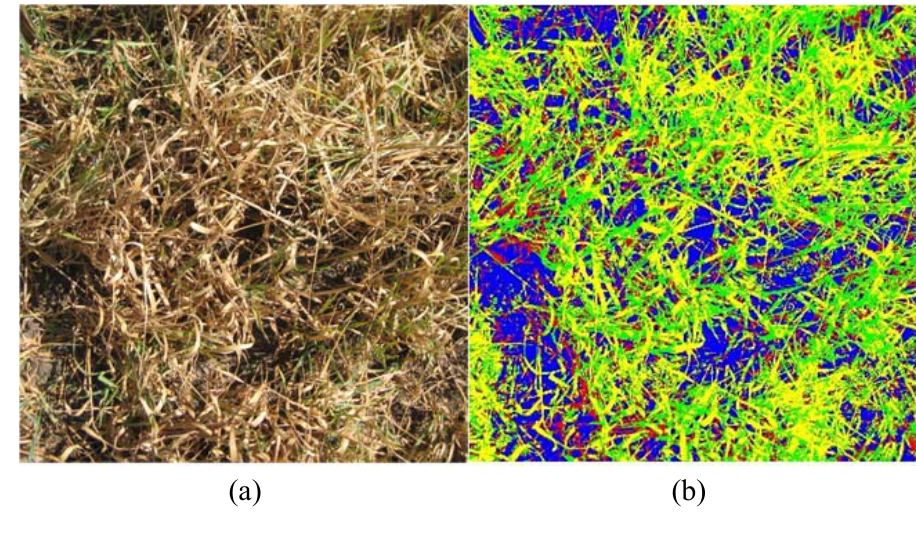
Figure 3. (a) Original image; (b) Classification results obtained by the unsupervised strategy (four